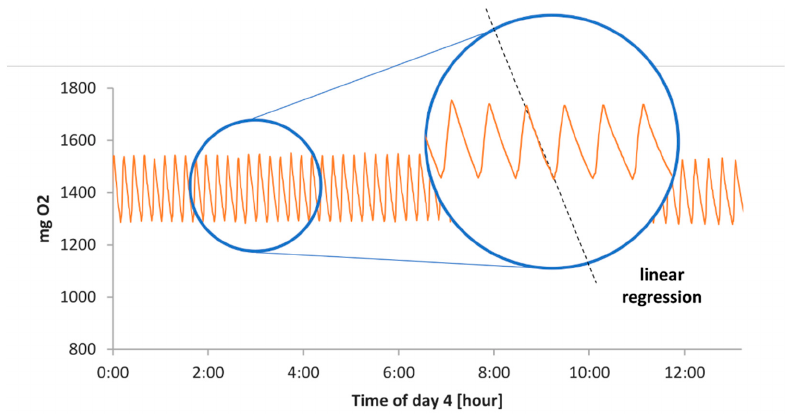
Figure A1. Plot of the oxygen mass inside the bioreactor calculated through Equation (2).